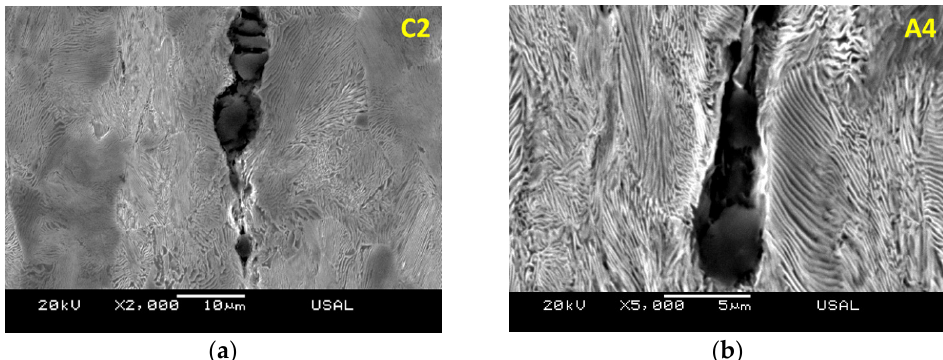
Figure 9. Inclusions in slightly drawn pearlitic steels C2 (with two drawing steps) and A4 (with four drawing steps). Principally MnS ( a ); complex oxide, mainly Al 2 O 3 ( b ).